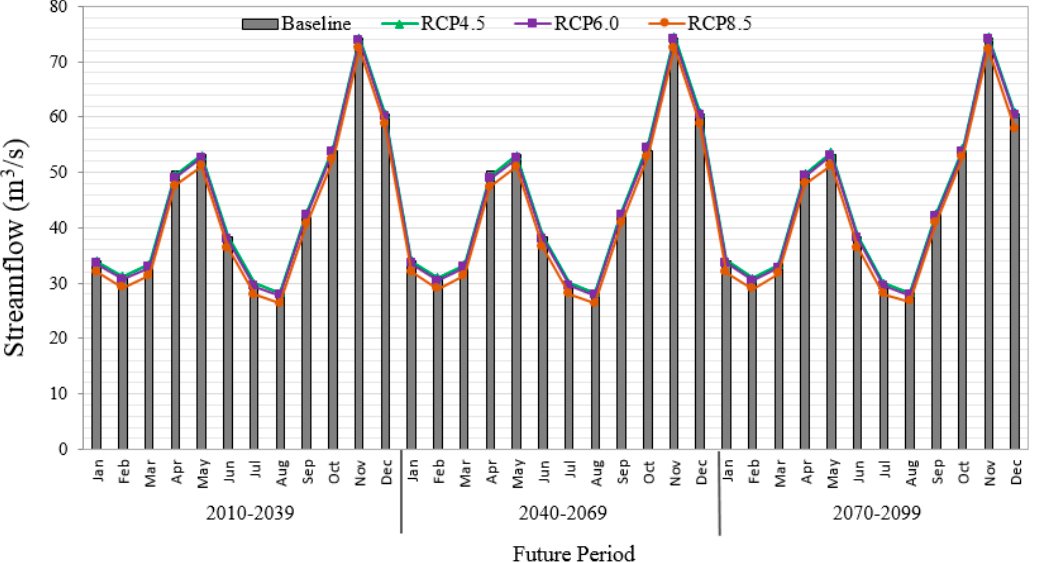
Figure 7. Projected mean monthly streamflow from multiple models for three RCP scenarios (RCPs